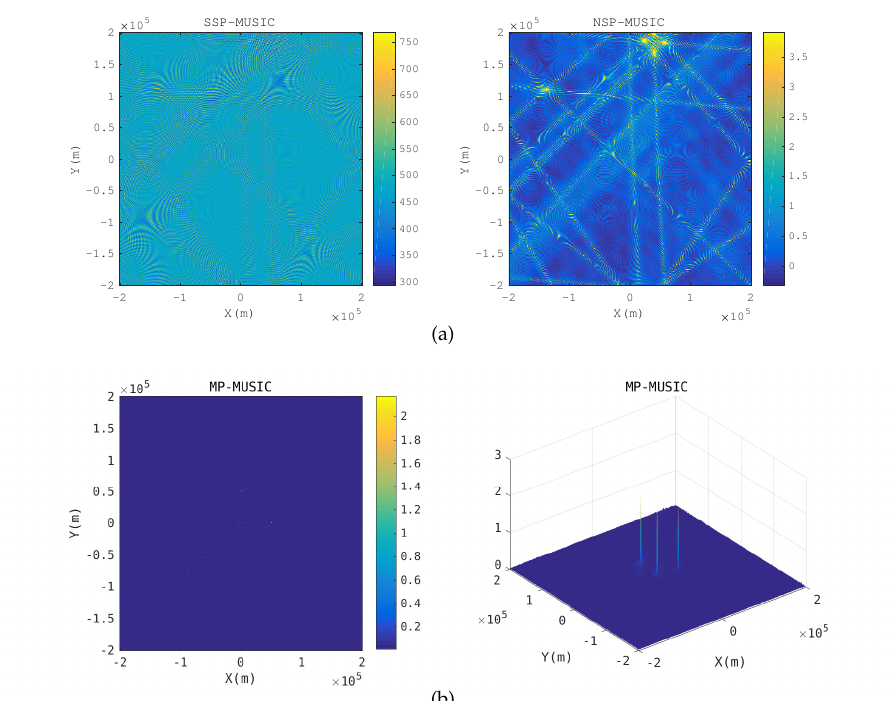
Figure 7. Spatial spectrum for a single antenna of each receiving array. ( a ) Spatial spectrum of SSP-MUSIC and NSP-MUSIC ( b ) Spatial spectrum of